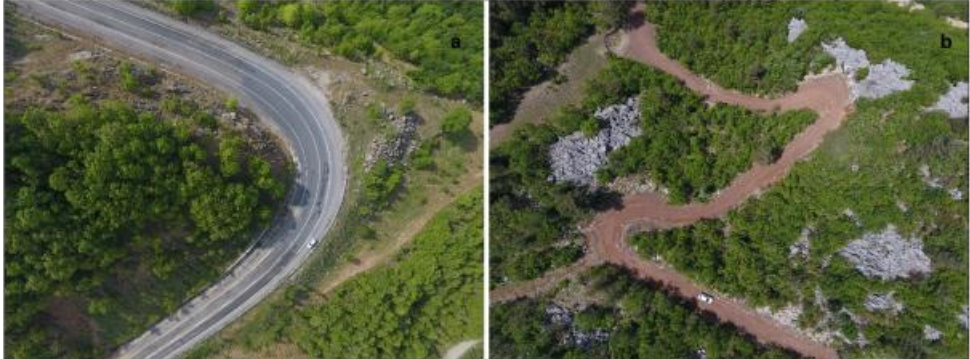
Figure 4. The latest drone images for the curve and sharp curve on the rural road ( a ) and forest road ( b ). All curve points were calculated based on the points on a helical spring instead of adjacent tangent lines. The point data of the measured curves were obtained from opposite road sidelines. Two different opposite measurements were performed on the beginning and end of the curve to find the actual curve radius and the middle point of the